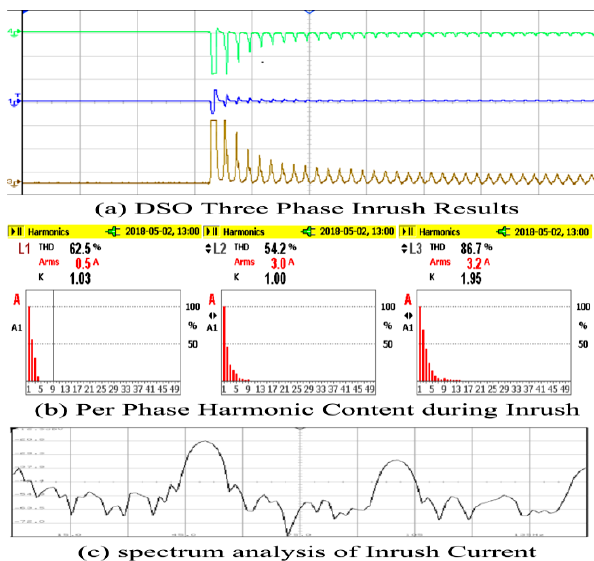
Fig. 7. Inrush condition: (a) Three Phase Inrush Currents waveform, (b) Per Phase Harmonic during inrush, (c) Spectrum analysis during